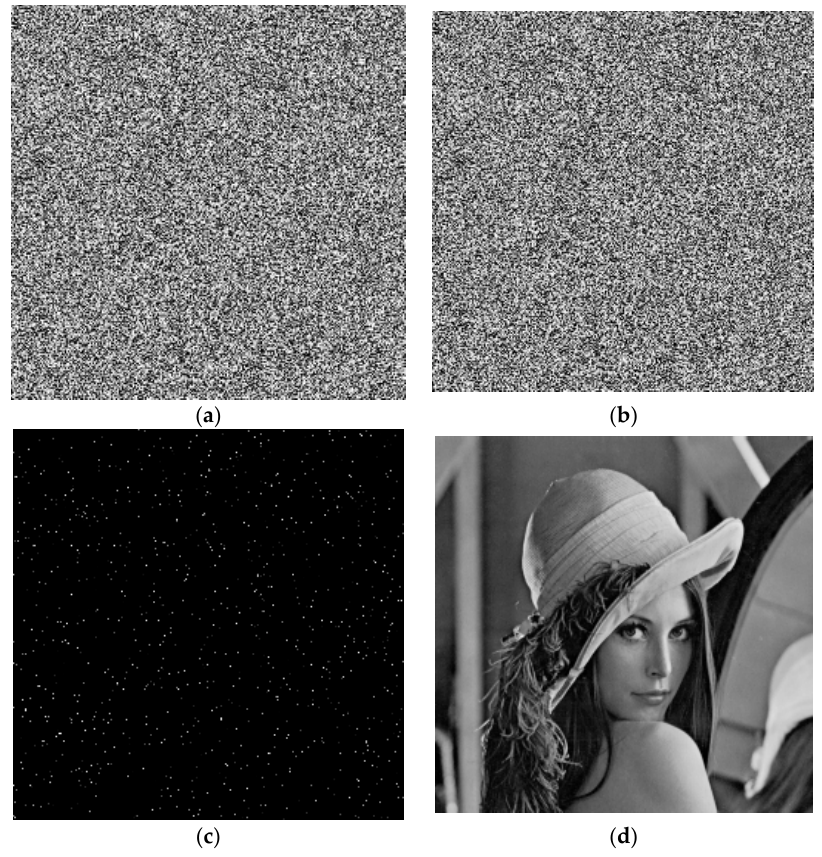
Figure 5. Correcting errors. ( a ) Containing errors image; ( b ) image after correcting errors; ( c ) Difference image; ( d ) Decrypted image after correcting errors.